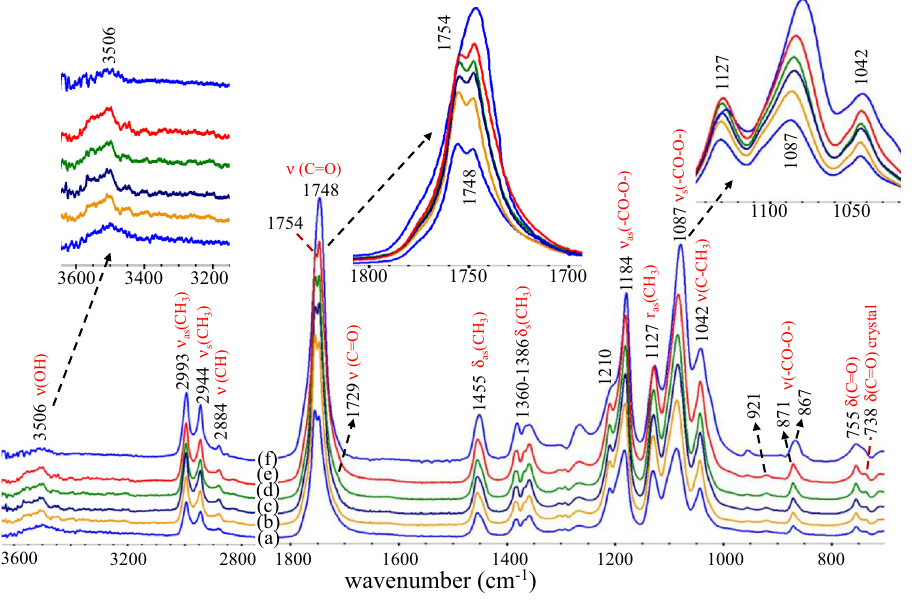
Figure 4. ATR-FTIR spectra of alcohol-acidolyzed PLA products: ( a ) LD6M, ( b ) LD12B0.2 M, ( c ) LD16B0.2 M, ( d ) LD12M, ( e ) LD16M, and ( f ) neat PLA.